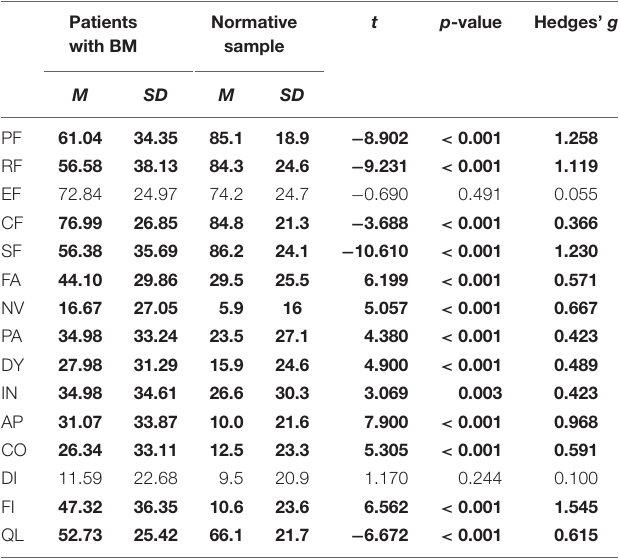
TABLE 2 | Comparison of QLQ-C30 scores in patients with BM ( n = 162) and a association between the sociodemographic/clinical/psychological normative sample of healthy controls ( n = 15386). variables and QLQ-C30 scores ( Table 4 ). The results indicated that SOC scores were significantly associated with QLQ-C30 total Patients Normative t p -value Hedges’ g scores ( r = 0.379, p < 0.001), while the other variables, including with BM sample gender, age, education level, marital status, possession of medical insurance, possession of religious belief, type of primary